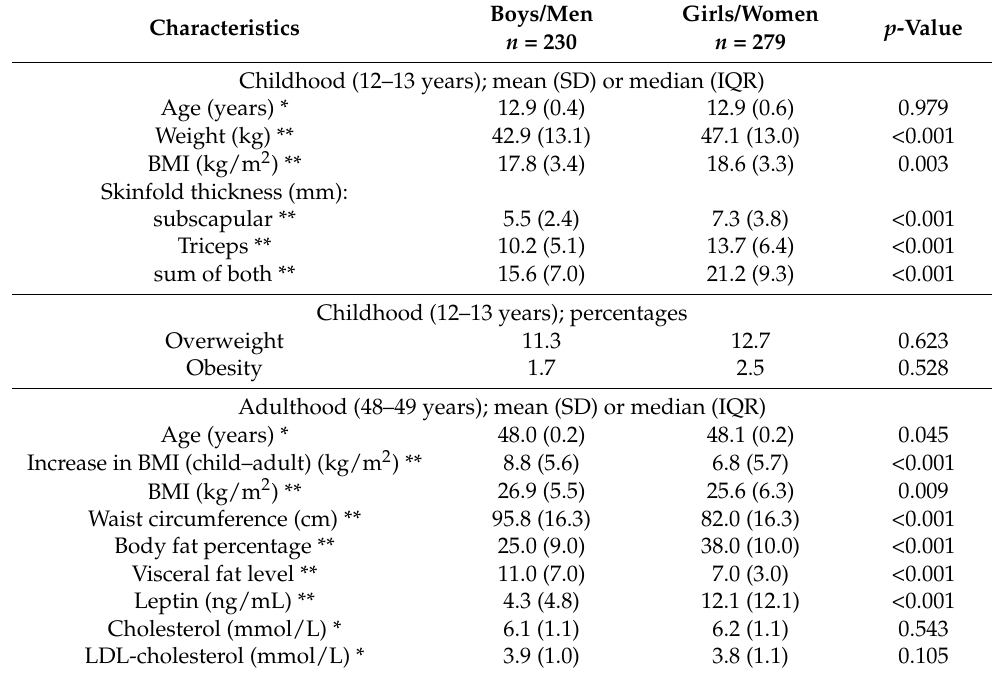
Table 1. Characteristics of the study